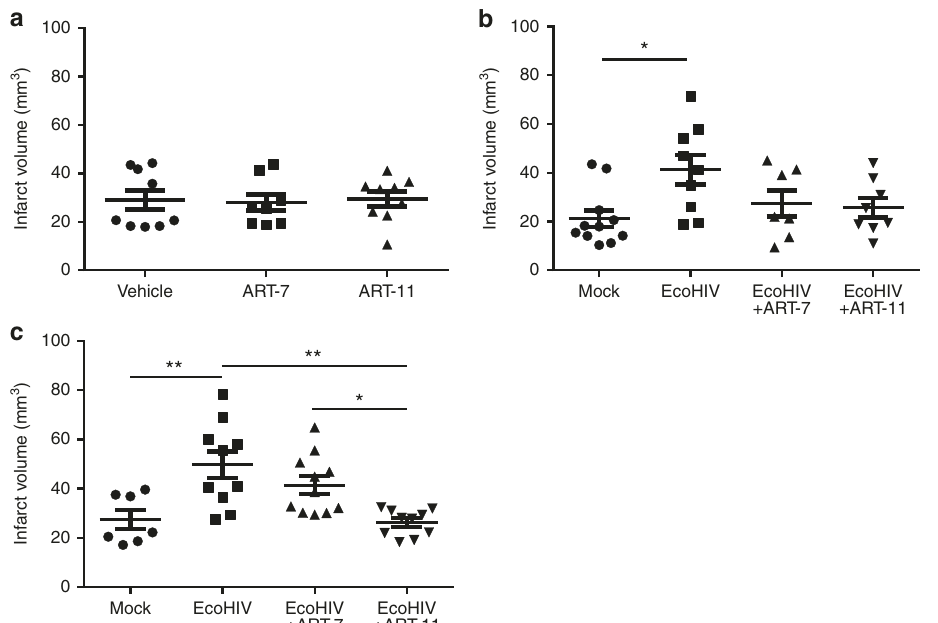
Fig. 6 ART CPE score correlates with post-stroke treatment outcome. a Quanti fi cation of infarct size of non-infected mice treated with ART-7 or ART-11. Mice were administered with antiretroviral drugs as ART-7 or ART-11 mixture for 2 weeks. Then, ischemic stroke was induced and infarct volume was assessed 24 h post-stroke. b , c Mice were infected with EcoHIV as in Fig. 1, and ART-7 or ART-11 was introduced one week later for 2 weeks. Then, ischemic stroke was induced, and infarct volume was evaluated after 24 h ( b ) or 7 days ( c ). ART continued to be administered post-stroke; n = 7 – 11 mice per group, 2 independent experiments. Data presented as mean and SEM. Source data are provided as a Source Data fi le. * p < 0.05 or ** p < 0.01; one-way ANOVA, followed by Tukey multiple comparison Figs. 6 and 7, and behavioral testing was performed at days 1, 4, 7 and 14 post-stroke. Signi fi cant differences in neurode fi cit score that affects primarily motor functions were detected between mock and Eco-HIV-infected mice at days 1, 7 and 14 post stroke (Fig. 8). EcoHIV-infected mice treated with ART-7 or ART-11 performed similarly to the mock-infected group. The comparison between the EcoHIV and EcoHIV + ART-11 was signi fi cantly different at days 1, 7, and 14 post stroke, while signi fi cant pro- tection by ART-7 was noted only at the later time points, such as days 7 and 14 post ischemic stroke.